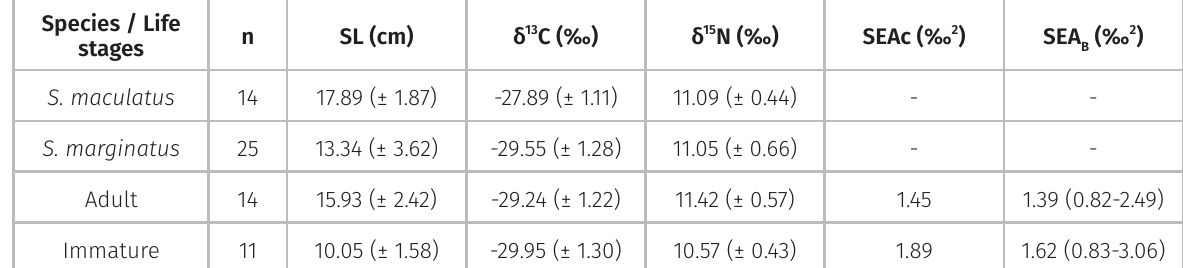
- lower and upper 95% confidence B